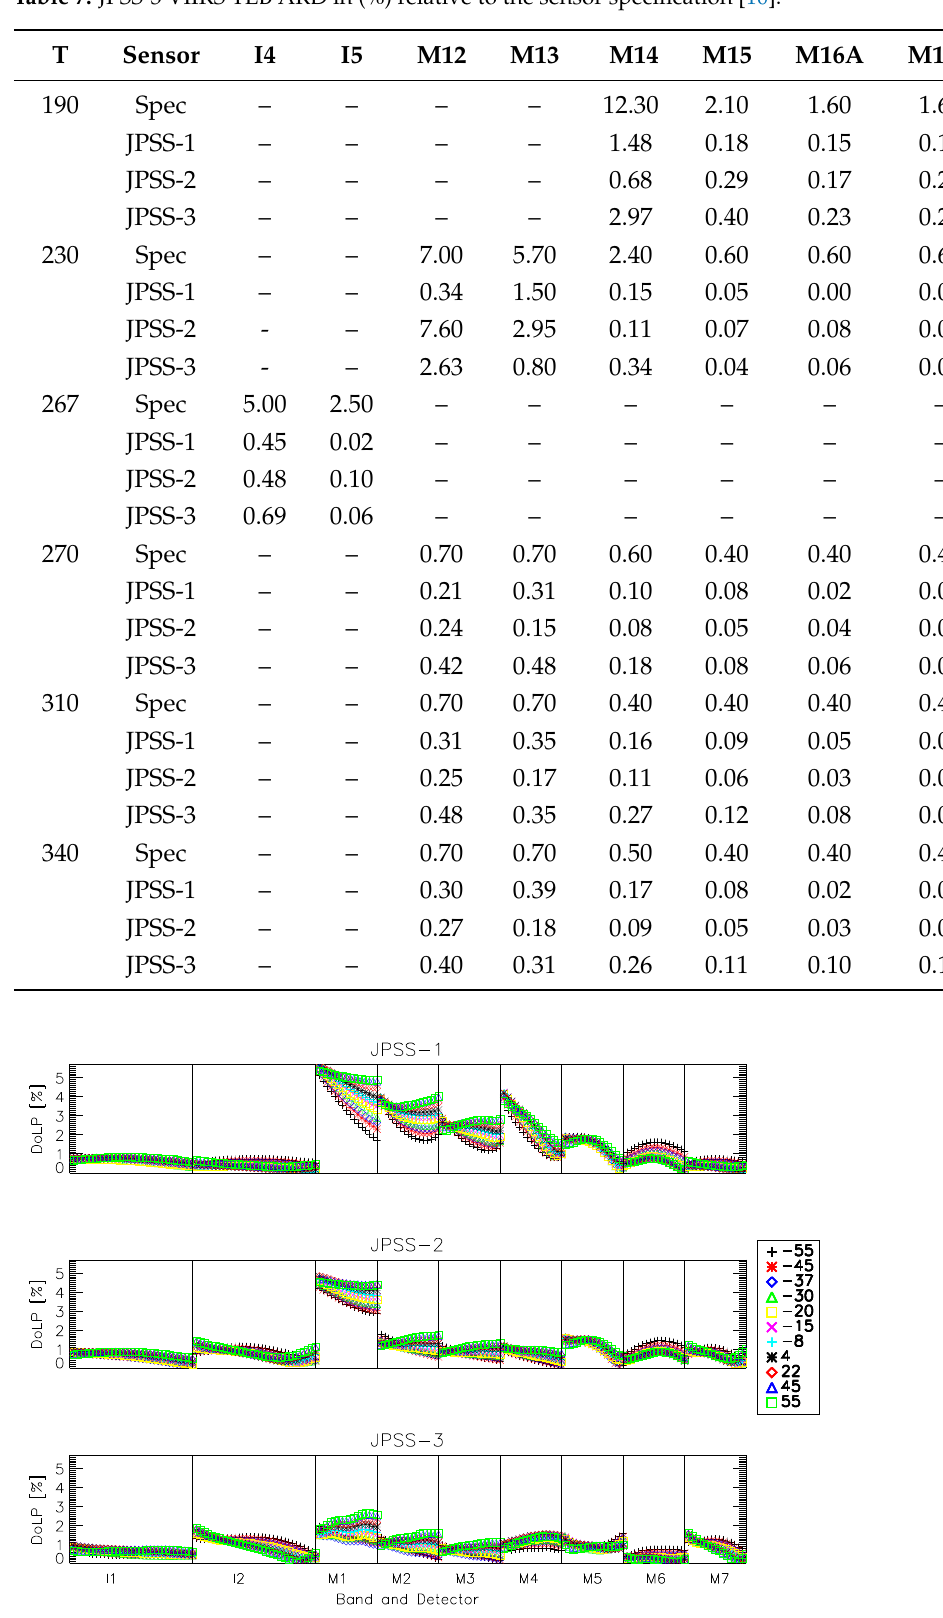
Figure 4. VIIRS DoLP per band and detector, across scan angles (symbols), for JPSS-1, JPSS-2, and JPSS-3 ( top to bottom